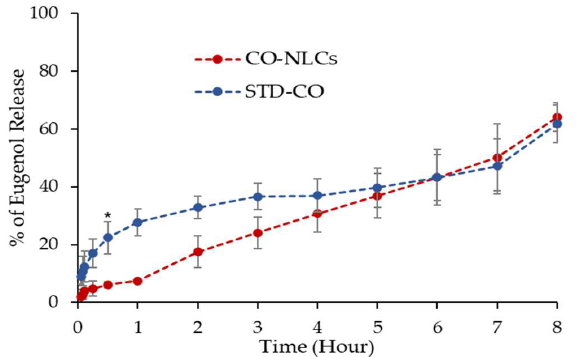
Figure 4. Eugenol release profile compared to the release profile from STD-CO and CO-NLCs at different timepoints. (*) indicates a significant difference ( t -test, p < 0.05) between STD-CO and CO- NLCs for the particular time point.